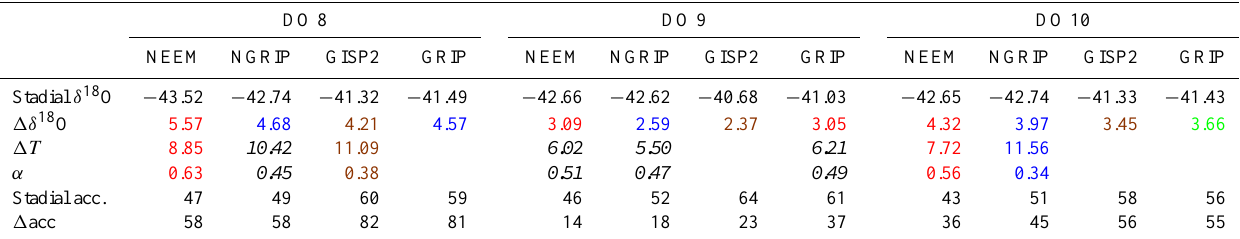
Table 3. DO increase (GI-GS) in δ 18 O, temperature and accumulation (mm.i.e.a − 1 ) for NEEM, NGRIP, GRIP and GISP2. For 1δ 18 O, 1T and α , for each given DO event, two numbers written with different colors are significantly different from each other. A number in italic is not significantly different from all other numbers. See text for details and Sect. B for uncertainties